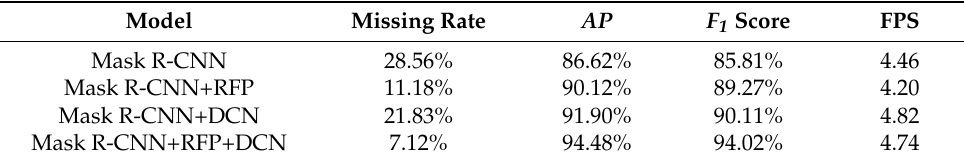
Table 4. Damage detection results in different improved stage